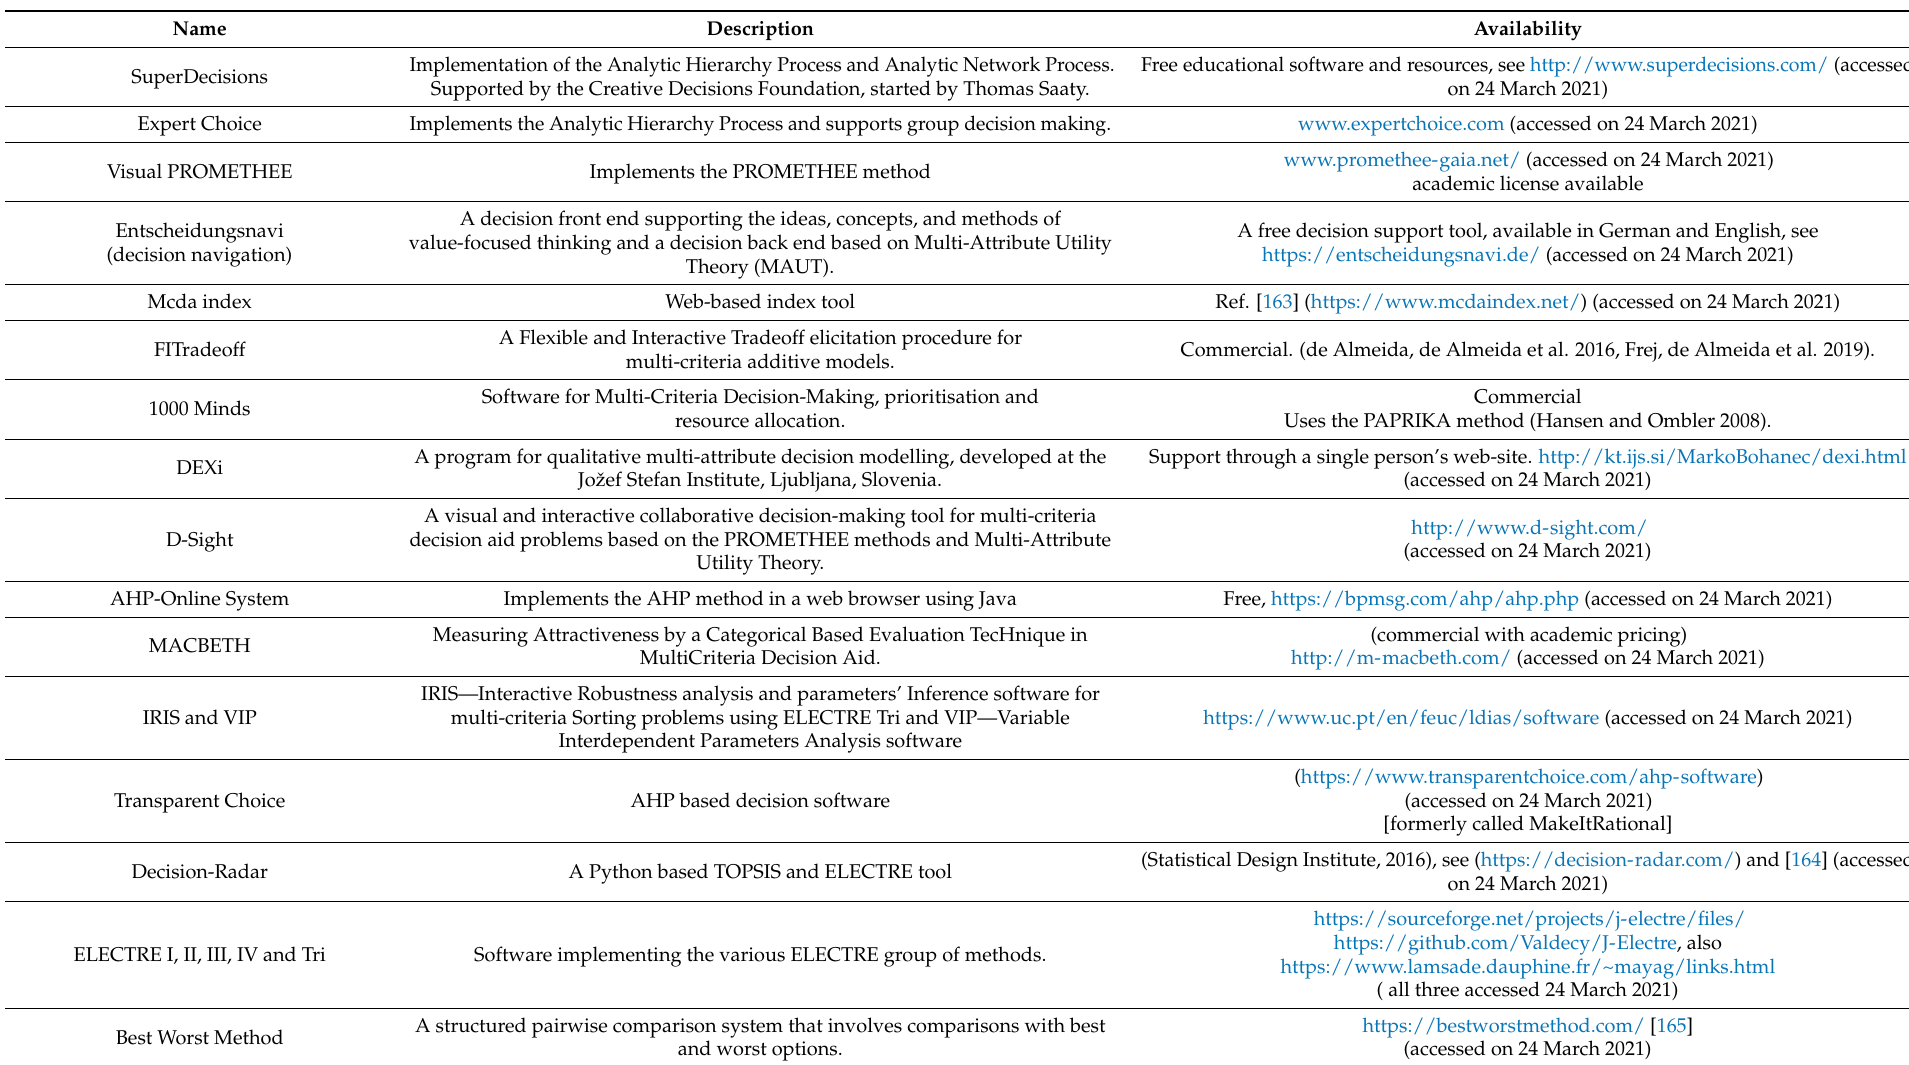
Table 15. MCDA Software packages—single